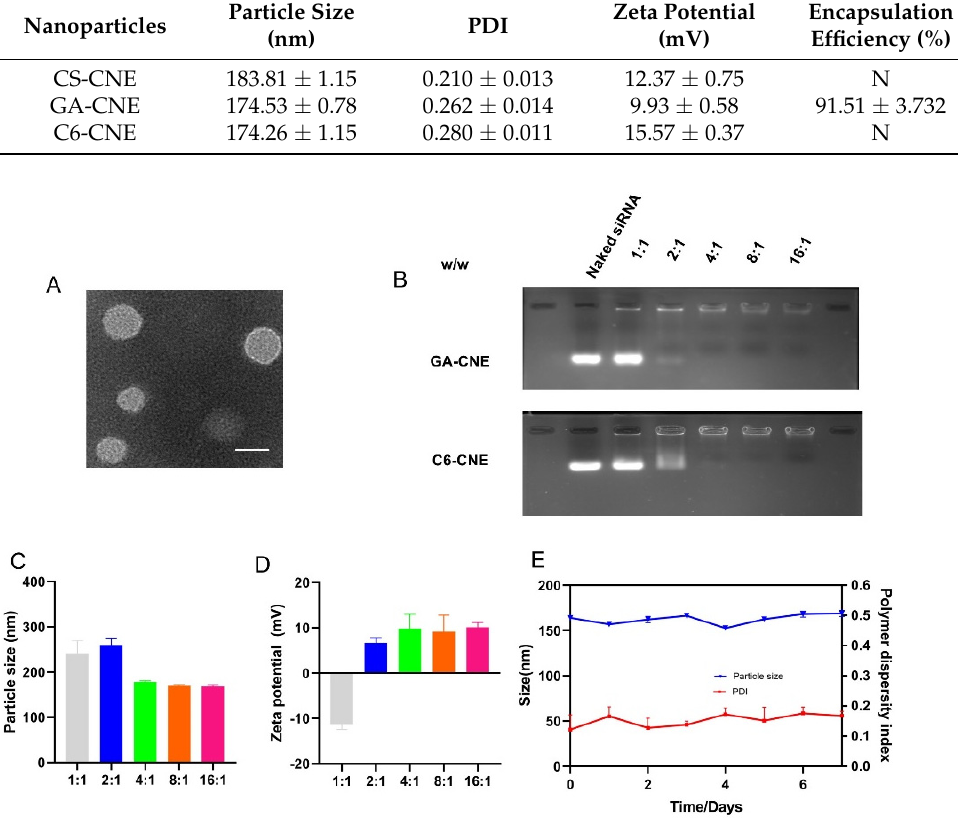
Figure 1. Characterization of CNE. ( A ) GA-SNE transmission electron micrograph. Scale bar: 200 Figure 1 . Characterization of CNE. ( A ) GA ‐ SNE transmission electron micrograph. Scale bar: 200